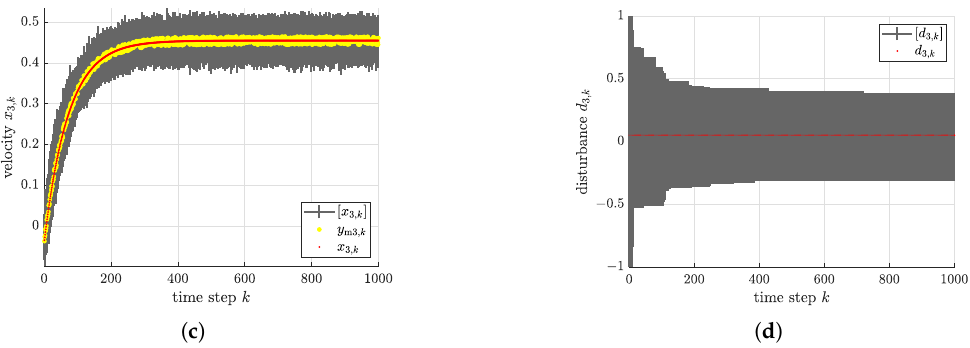
Figure 13. Comparison of the estimation results with noisy measurements and true system states for (cid:2) (cid:3) x 1, k the case of small uncertainties (92). ( a ) Estimated bounds vs. measured and true velocities y m1, k (cid:2) (cid:3) x 2, k and x 1, k . ( b ) Estimated bounds vs. measured and true velocities y m2, k and x 2, k . ( c ) Estimated (cid:2) (cid:3) x 3, k bounds vs. measured and true velocities y m3, k and x 3, k . ( d ) Estimated bounds disurbance d 3, k =